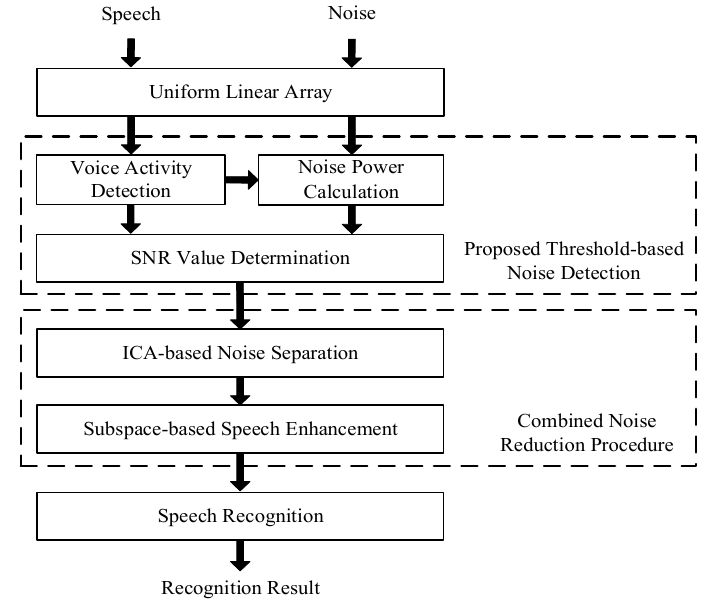
Figure 1. Overview of proposed system.